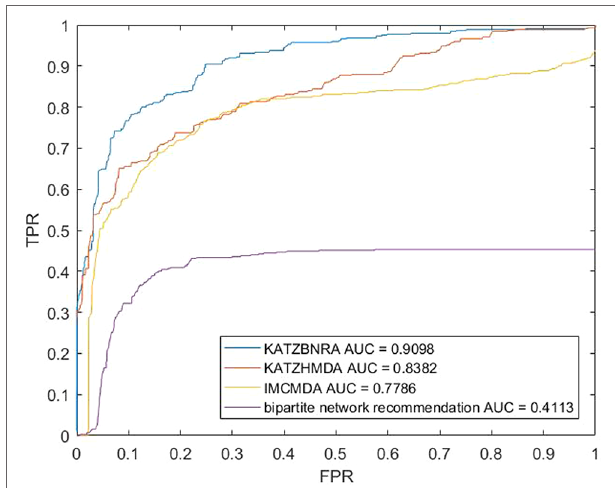
FIGURe 4 | The LOOCV experimental results of KAZTBNRA, KATZHMDA, IMCMDA, and the native bipartite network recommendation.